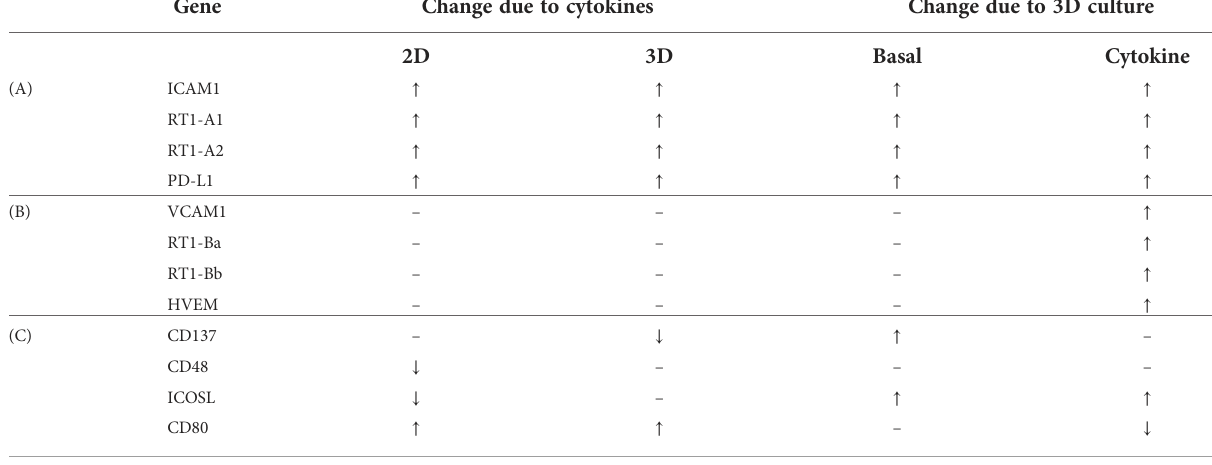
TABLE 1 Summary of gene expression changes in adhesion, MHC, and co-stimulatory